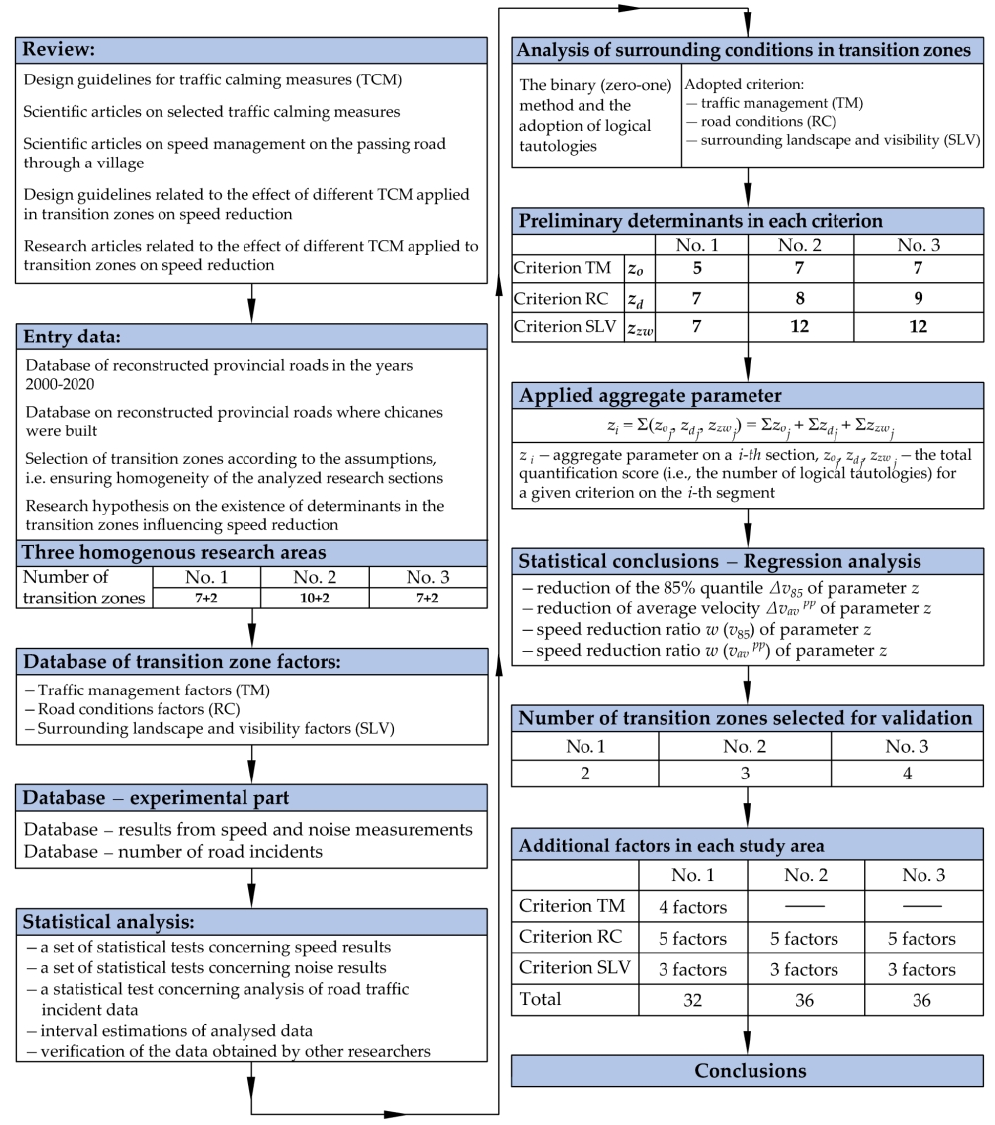
Figure 7. Flow chart of applied methodology. Source: own work of the authors.